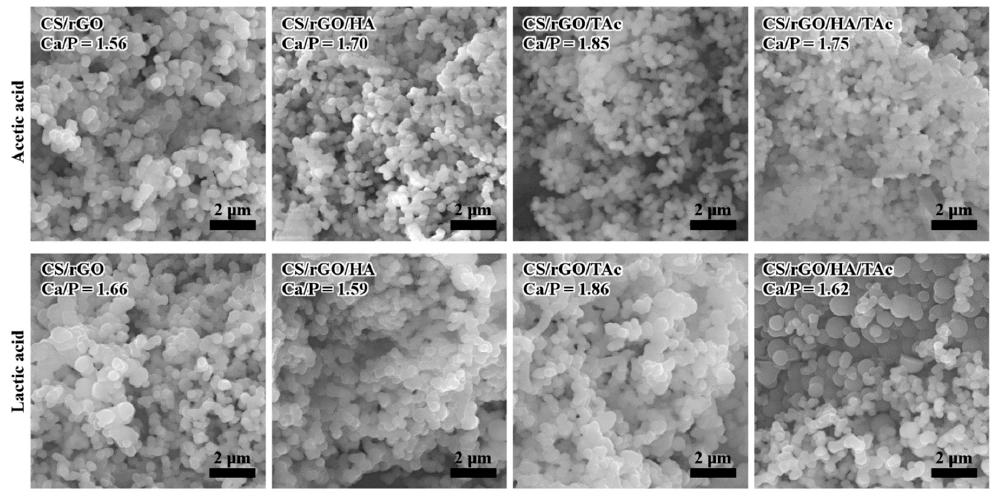
Figure 7. Representative SEM (Scanning Electron Microscopy) images of the surface of CS nanocomposites after 28 days of incubation in SBF solution (CS—chitosan, rGO—reduced graphene oxide, HA—hydroxyapatite, TAc—tannic acid).